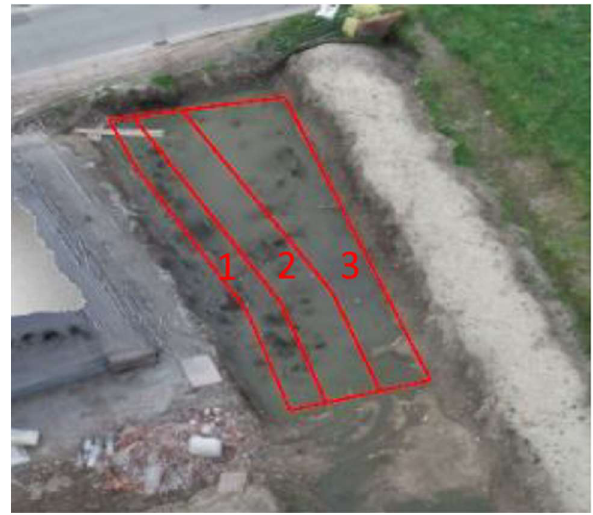
Figure 15: Part of the testsite in Mariakerke with a water accumulation for three objects. Table 3: The influence of water in the volume